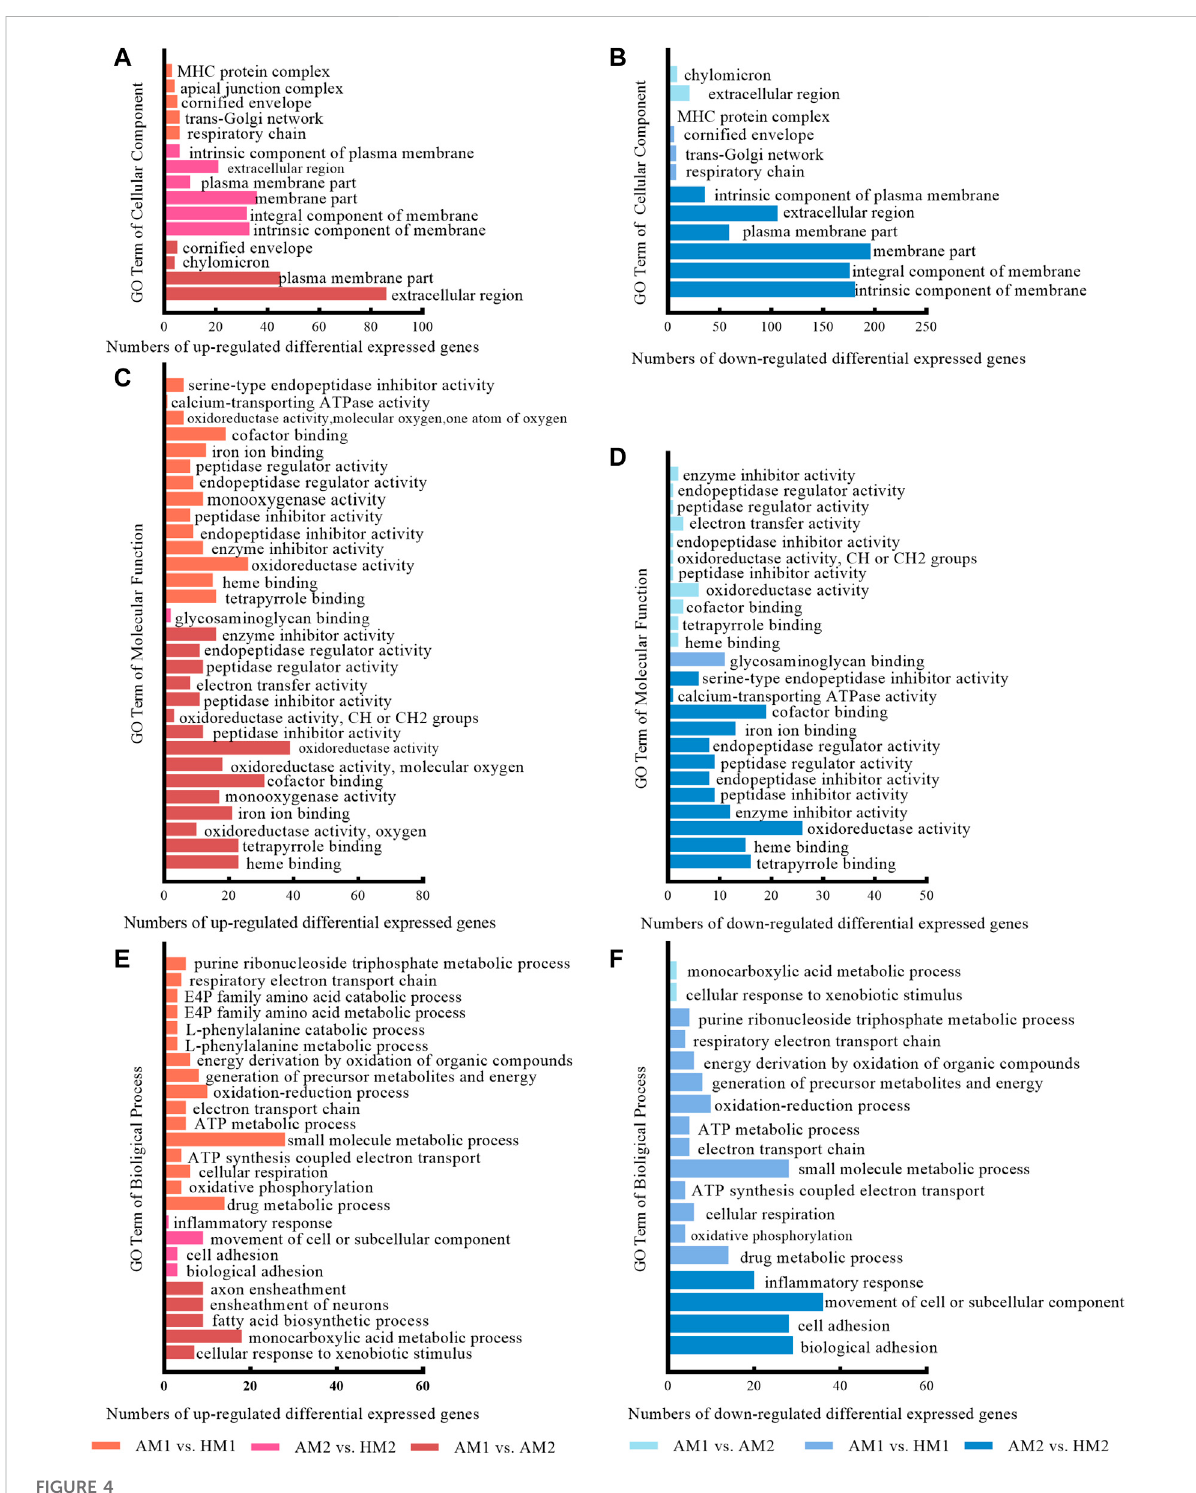
FIGURE 4 Thesigni fi cantlyenrichedgeneontology(GO)termsbetweenAltayandHulambsat − 5 ° Cand20 ° CinAltayandHubreeds.AM1vs.HM1:muscle tissue of Altay lambs at − 5 ° C compared with Hu lambs at − 5 ° C; AM2 vs. HM2: muscle tissue of Altay lambs at 20 ° C compared with Hu lambs at 20 ° C; AM1 vs. AM2: muscle tissue of Altay lambs at − 5 ° C compared with lambs at 20 °